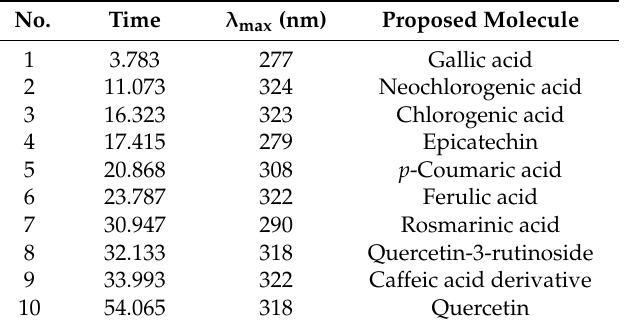
Table 1. Main phenolic compounds in mint extract identified by